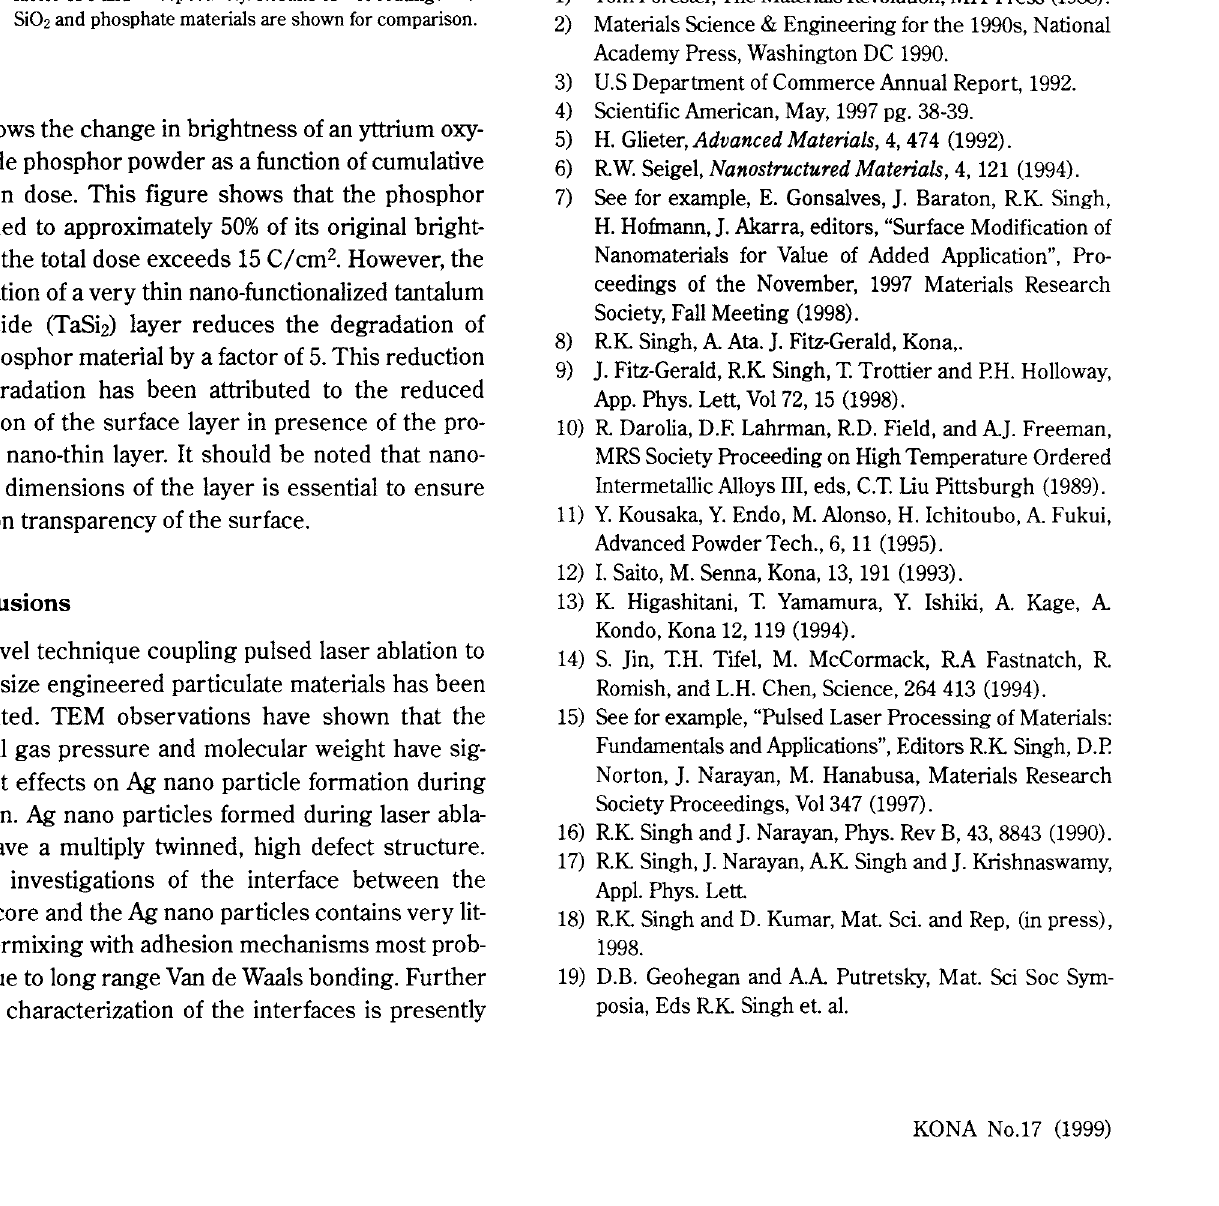
This figure shows that during cathodoluminescent degra dation, the uncoated phosphor material (Y 2 0 2 S:Eu 3 +) degraded to approximately 50% of its original brightness if the total dose exceeds 15 C/ cm 2 (standard industrial con ditions for a phosphor lifetime). However, the application of very thin nano-functionalized tantalum di silicide (TaSiz) and Ag layers by the laser ablation process reduces the degradation of this phosphor material by a factor of 5 and 2 respectively. Results of wet coatings with Si0 2 and phosphate materials are shown for